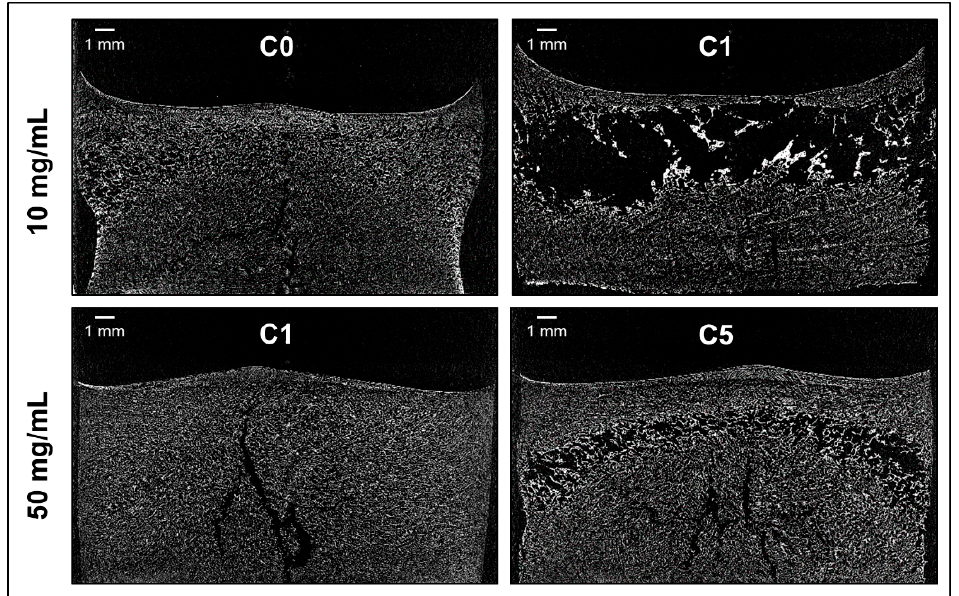
Figure 3. Internal cake structure of F S . Representative micro-computed tomography (µ-CT) images for 10 and 50 mg/mL formulations freeze-dried with different lyophilization cycles.